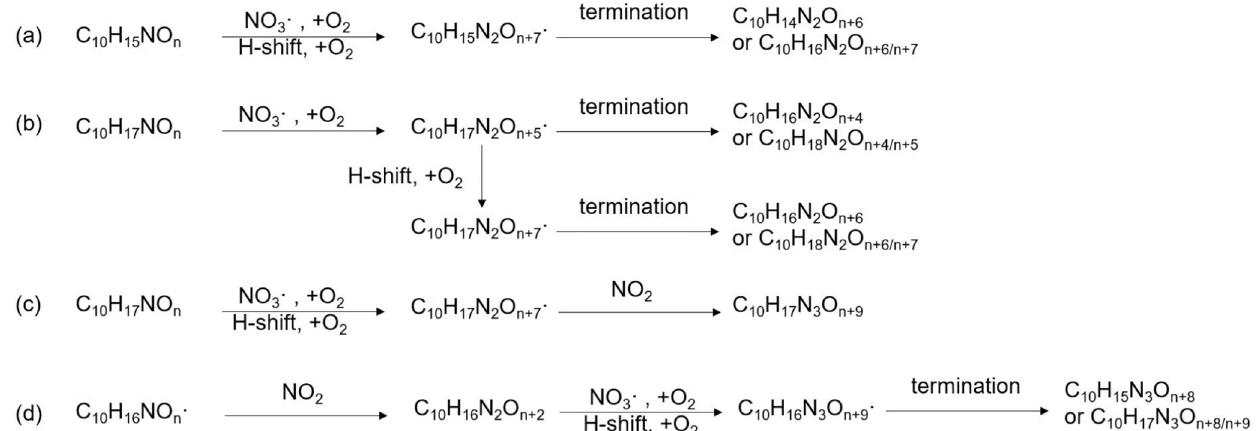
Scheme 2. Possible formation pathways of C 10 -monomers containing 2 nitrogen atoms (a, b) and 3 nitrogen atoms (c, d) . Termination (cid:113) (cid:113) denotes reactions of RO with other RO or HO 2 , or unimolecular reactions, leading to closed-shell 2 2